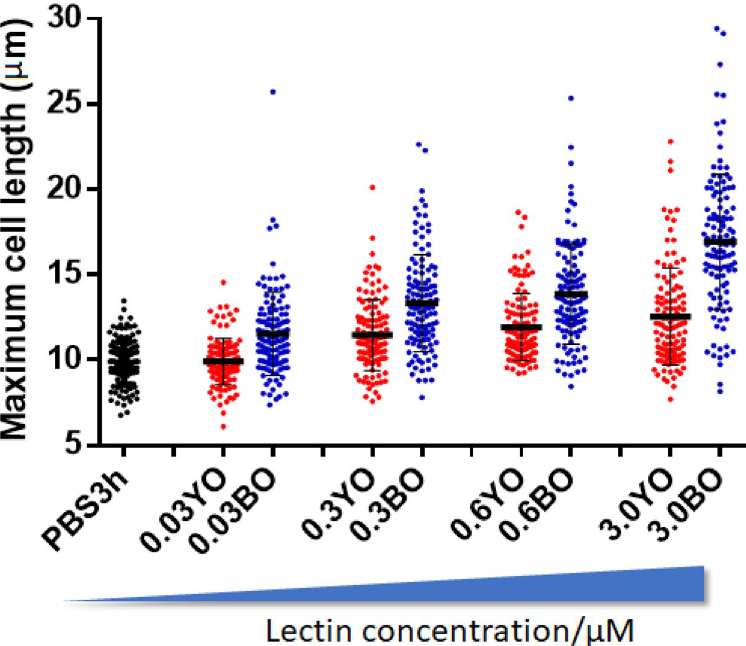
Figure 6. rOrysata induced cell spreading. 10 5 cells were seeded overnight in a 24 well plate before addition of YOry (YO) or BOry (BO) to a final concentration of 3, 0.6, 0.3, and 0.03 µM. PBS was used as control. After an 3 h incubation, maximum cell length was measured using the ImageJ software. In total 120 cells were measured from 4 independent replicates. Statistical analysis results are shown in Table S1.